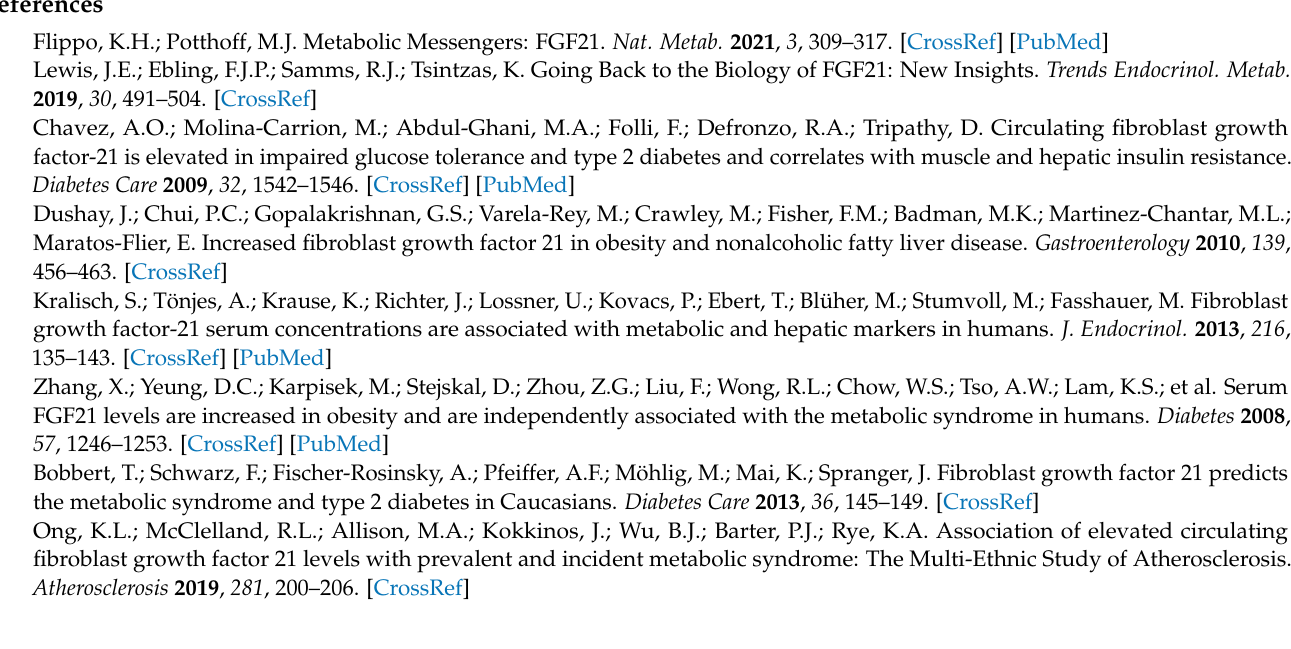
Figure S1: Scatter plots of fasting plasma FGF21 and the postprandial plasma FGF21 response upon a liquid high-fit mixed meal with markers of metabolic health; Table S2: Correlations between the change in fasting plasma FGF21 and the change in metabolic health markers upon a 12-week diet; Table S3: Correlations between the change in the postprandial plasma FGF21 response upon a liquid high-fit mixed meal and the change in metabolic health markers upon a 12-week diet; Table S4: Ranges and means of tertiles of habitual nutrient intake, alcohol consumption, and sweet-taste